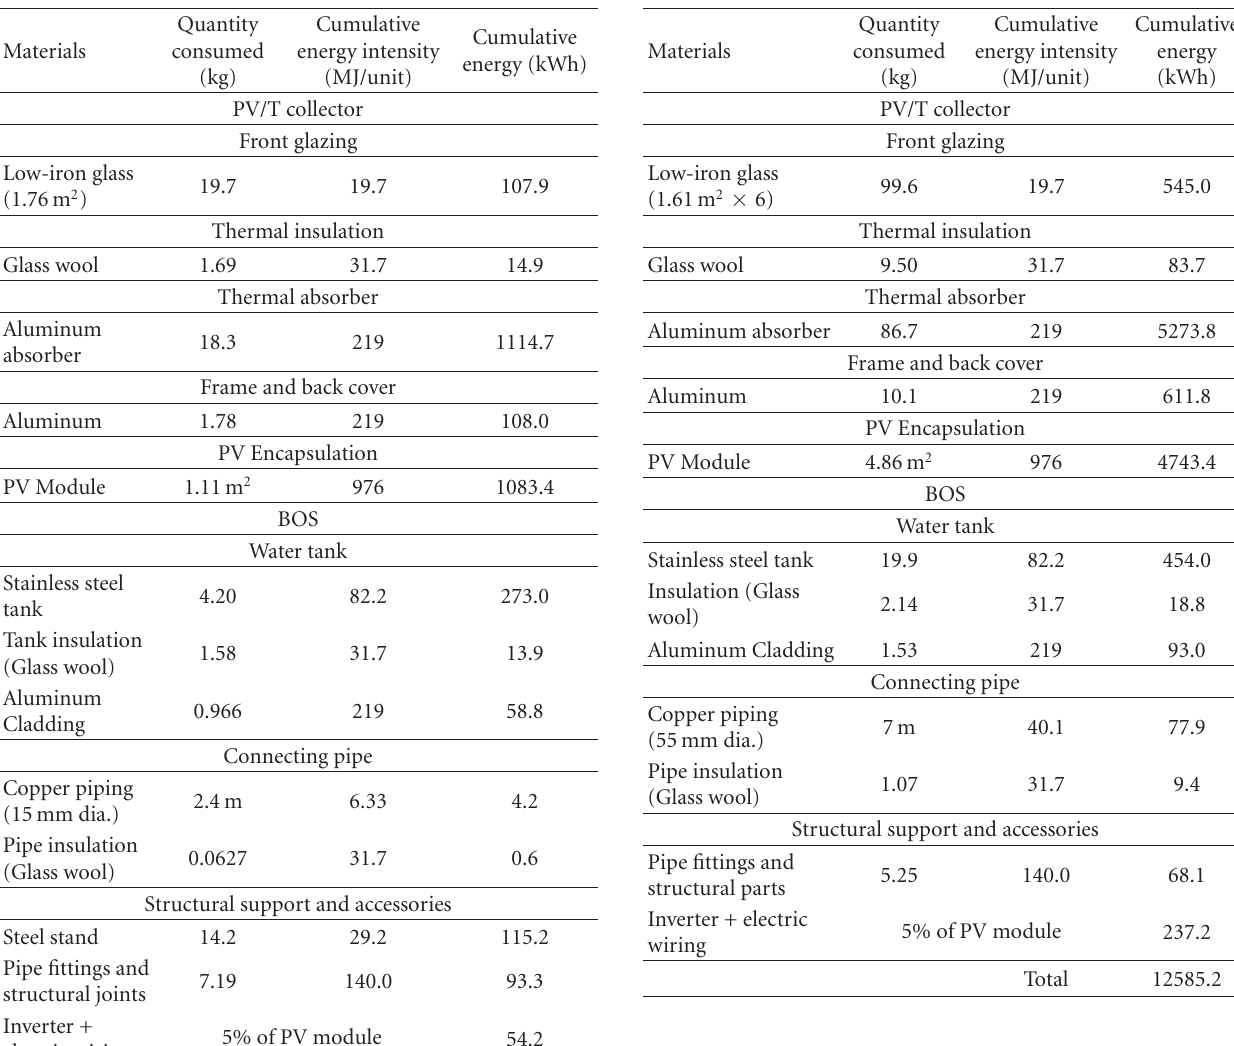
Table 3: Cumulative energy in free-stand PV/T system.